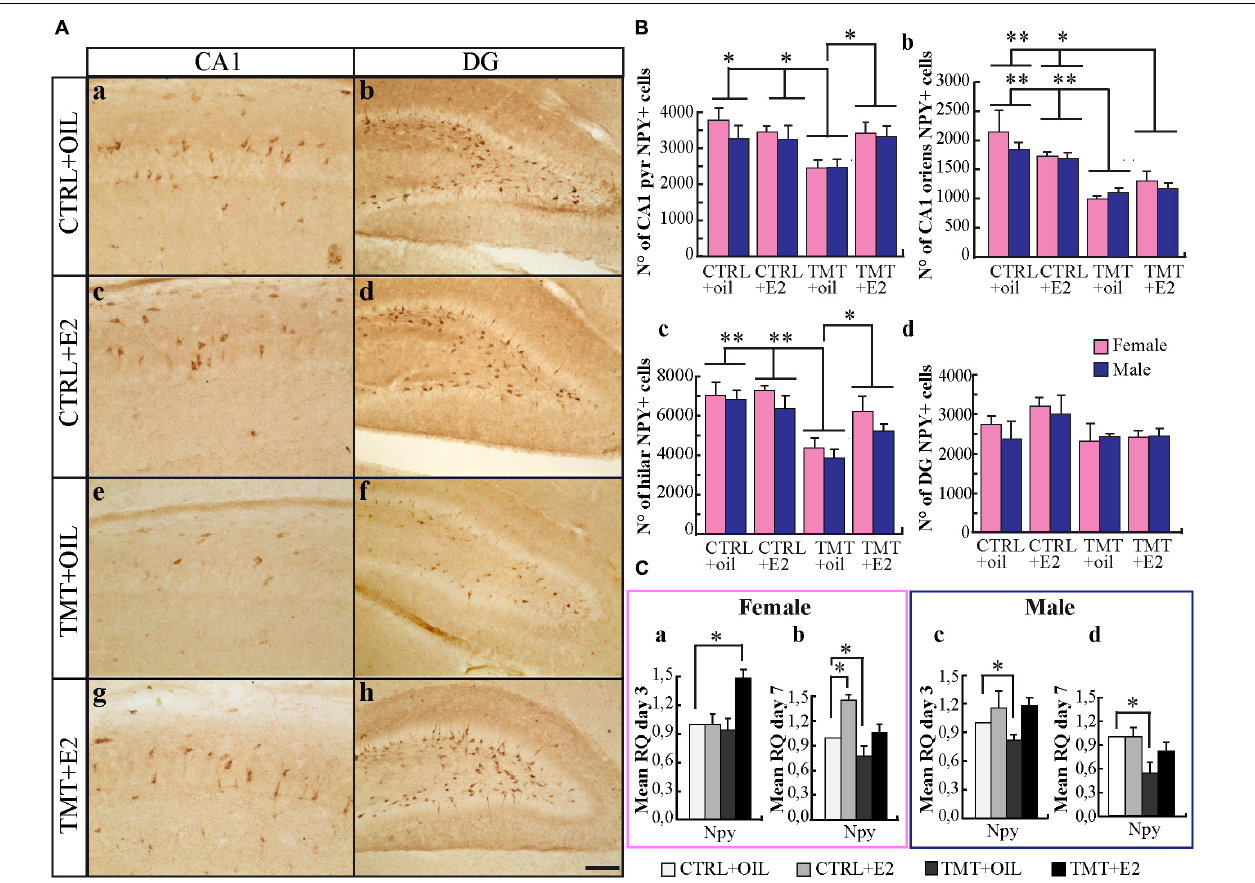
FIGURE 3 | (A) Distribution of neuropeptide Y (NPY)-immunostaining in the hippocampus of the different experimental groups. Representative micrographs of NPY-stained hippocampal sagittal sections from CA1 (a,c,e,g) and dentate gyrus (DG)/hilus (b,d,f,h) hippocampal subfields from CTRL+oil- (a,b)